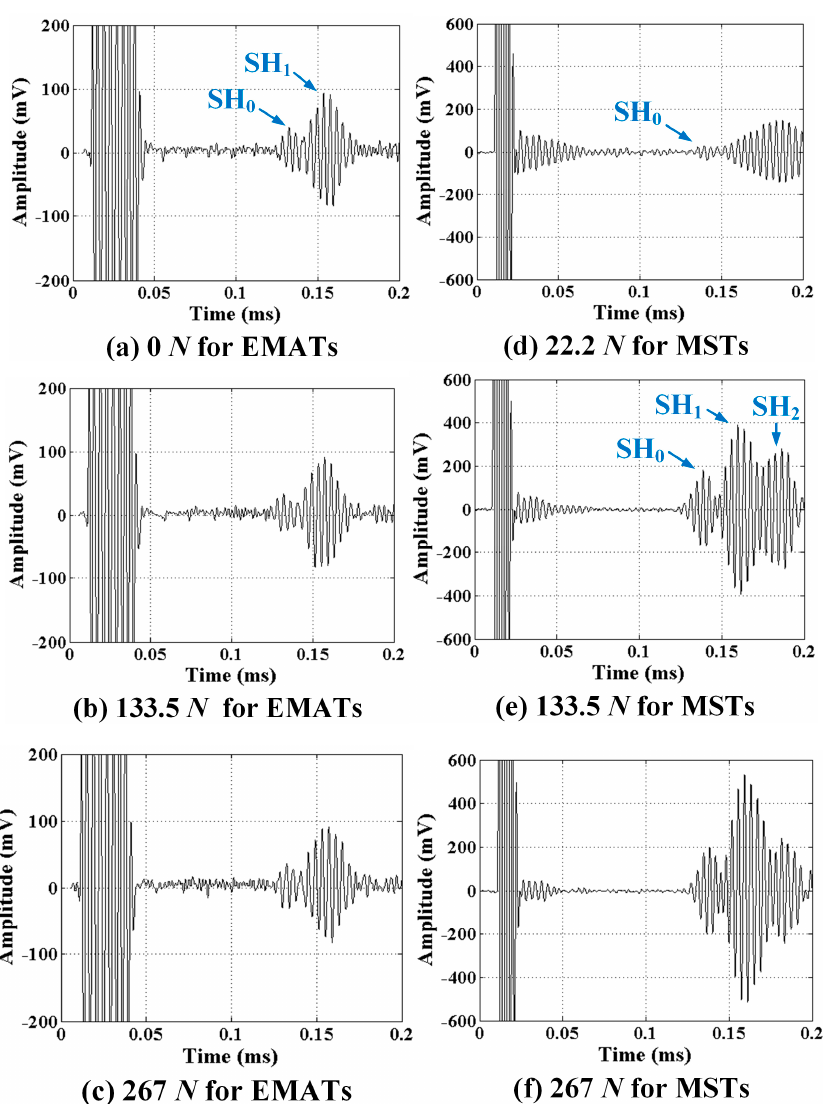
Figure 9. SH wave signals at different normal forces of: ( a ) 0; ( b ) 133.5; of ( c ) 267 N for EMATs; and ( d ) 22.2; ( e ) 133.5; and ( f ) 267 N for MSTs. Note that the signal prior to 0.04 ms is electromagnetic interference.